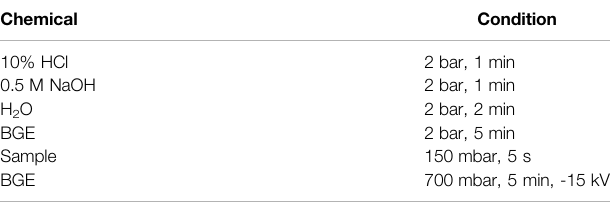
TABLE 2 | Conditions for capillary electrophoresis and Fe (II)/Fe (III) Speciation. Chemical